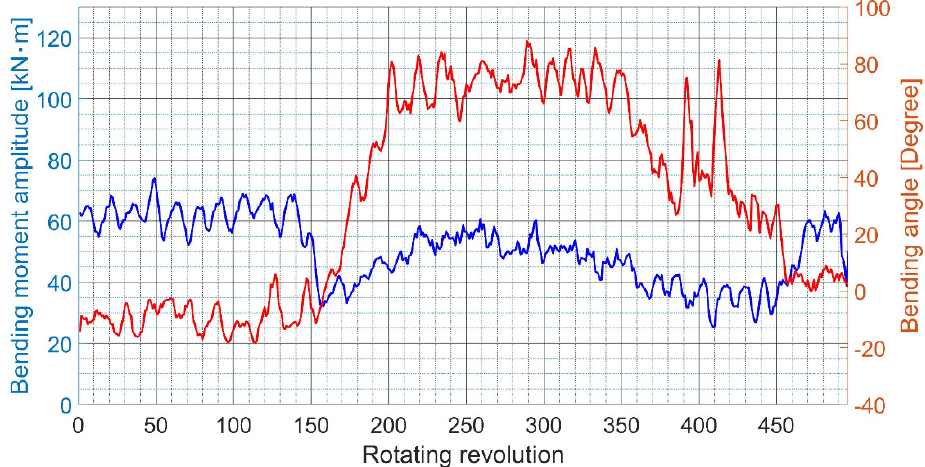
Figure 19. Bending moment during the port turn under the normal ballast condition.